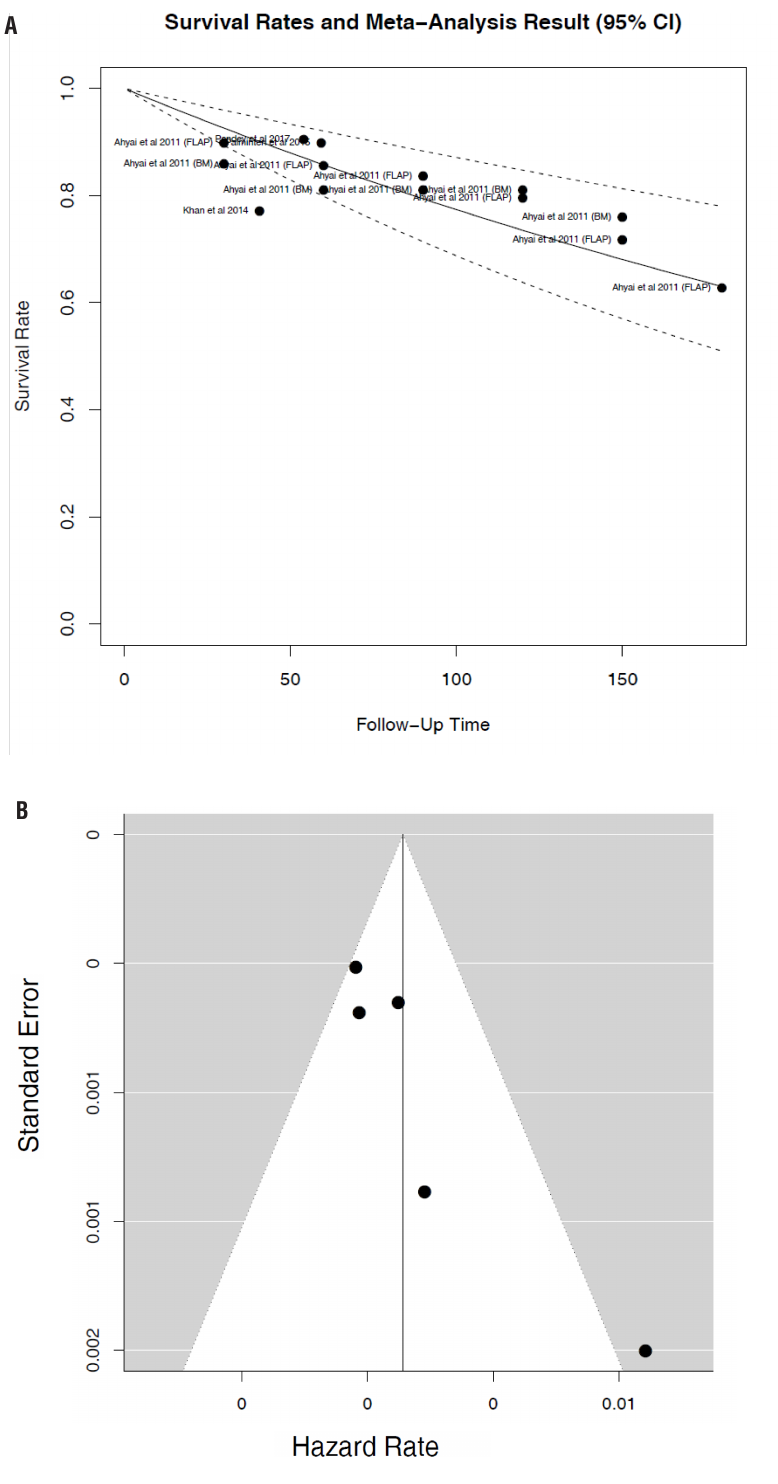
Figure 4 - A) Sub-Analysis- Estimated Kaplan-Meier curve overlay on the survival rates from each study included in the meta-analysis, when excluding studies using penile skin grafts and reporting patients with a history hypospadias and lichen sclerosus. B) Funnel Plots of the same studies, indicating less publication bias than seen in the full